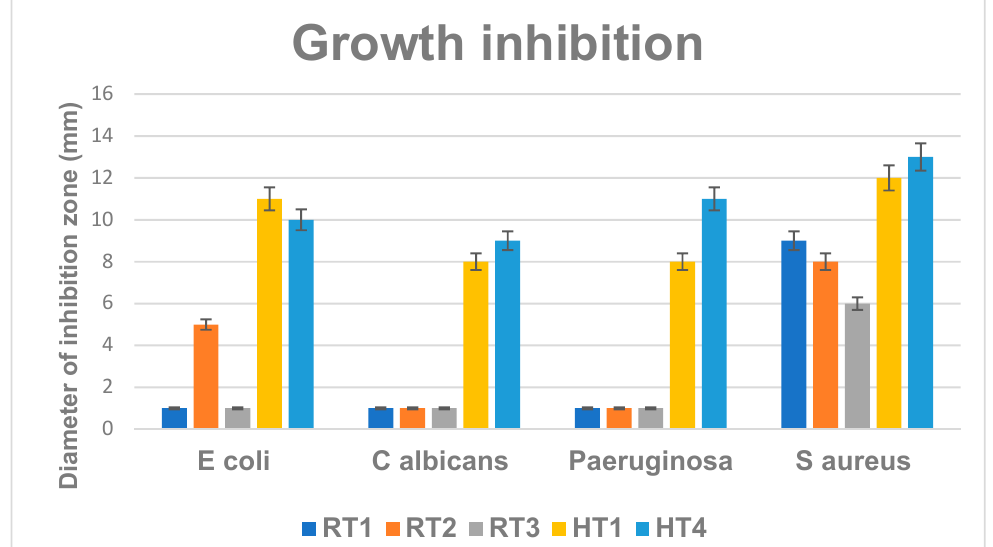
Figure 14. Graphic representation of growth inhibition zones ( mm ) developed after 24 h of incubation of microbial strains in the presence of the obtained NPs .